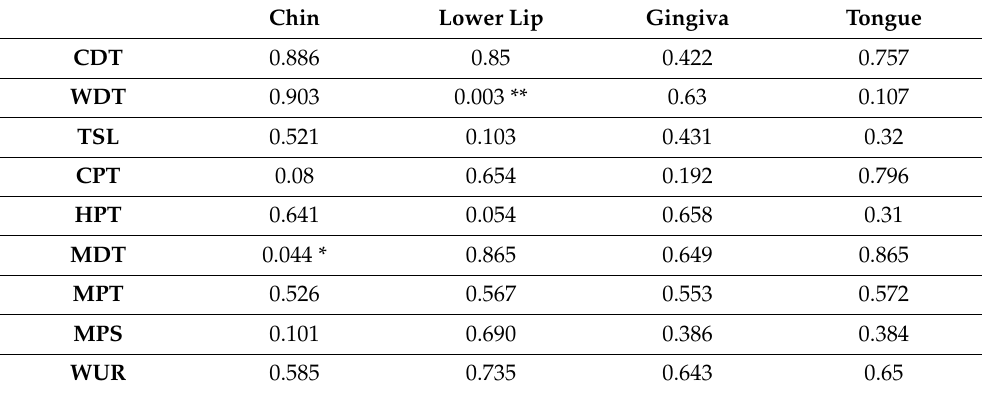
Table 2. Analysis of side effects for orofacial reference data ( p -values/Student’s t -test). (CDT = Cold Detection Threshold, WDT = Warm Detection Threshold, TSL = Thermal Sensory Limen, CPT = Cold Pain Threshold, HPT = Heat Pain Threshold, MDT = Mechanical Detection Threshold, MPT = Me- chanical Pain Threshold, MPS = Mechanical Pain Sensitivity, WUR = Wind Up Ration). * p < 0.05; ** p < 0.001.